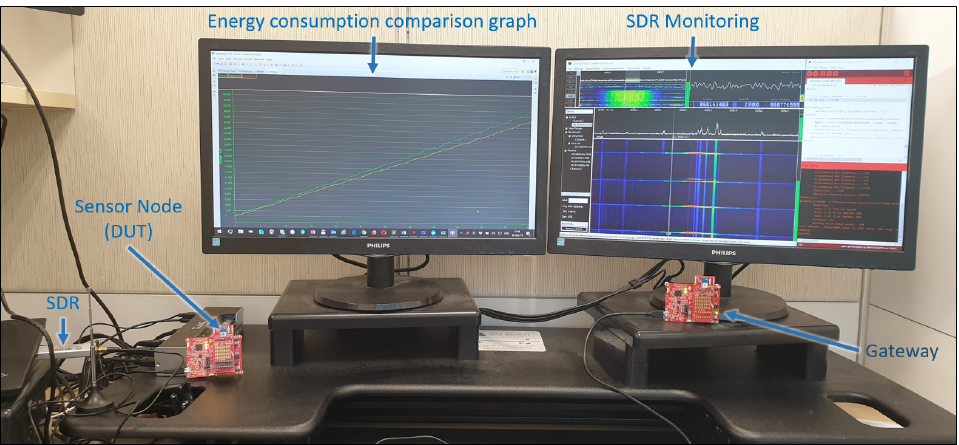
Figure 10. Performance evaluation